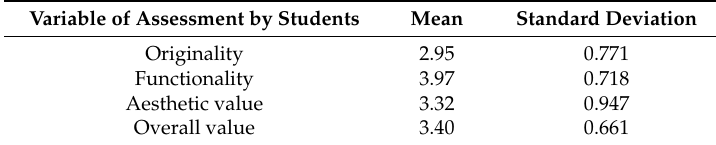
Table 2. The means and standard deviations of the creativity variables assessed by the students a .